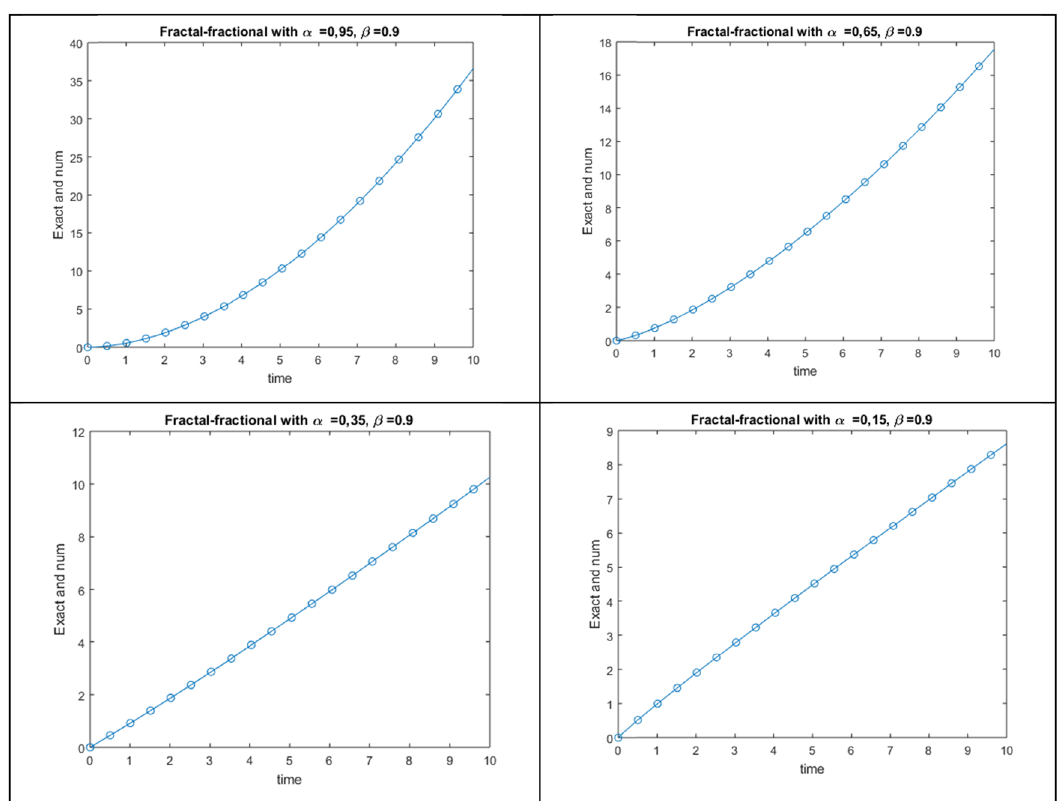
Figure 2: Numerical solution with the generalized Mittag - Le ffl er